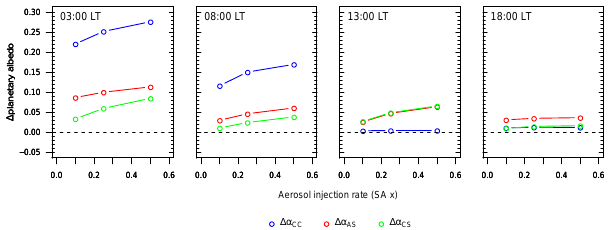
Fig. 9. Domain and time average albedo perturbations associated with SA0.1, SA0.25 and SA0.5 aerosol injection rates at 03:00:00 LT, 08:00:00 LT, 13:00:00 LT and 18:00:00 LT into the weakly pre- cipitating (WP) regime. In each case, three measures of the effects of aerosol injection on albedo perturbations are shown: the change in cloud albedo ( 1α CC ) ; the change in all-sky planetary albedo ( 1α AS ) ; and the change in clear-sky albedo ( 1α CS )